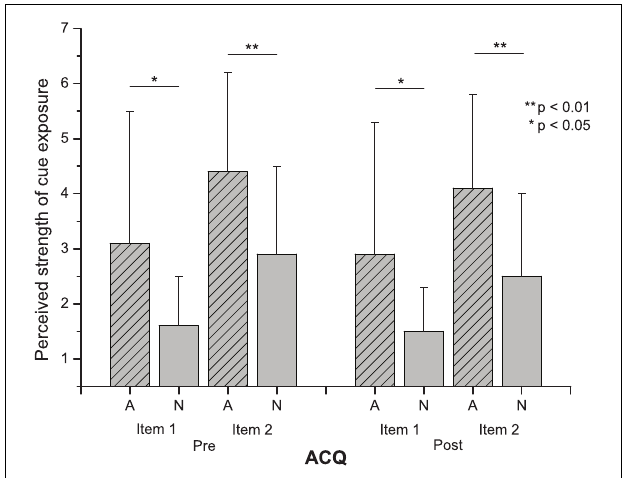
FIGURE 2 | Exposure of alcohol and control conditions.